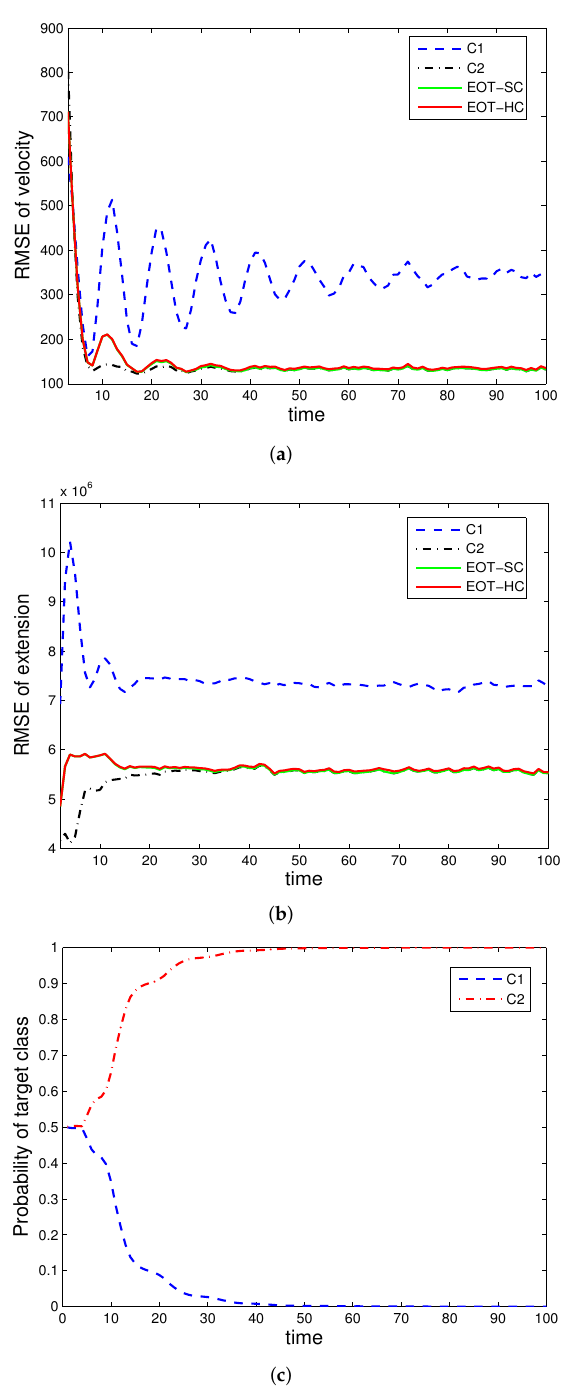
Figure 1 is the simulation results with only kinematic measurement under the true class c 1 ; Figure 2 is the simulation results with only kinematic measurement under the true class c 2 ; Figure 3 is the simulation results with both kinematic and attribute measurements under the true class c 1 ; Figure 4 is the simulation results with both kinematic and attribute measurements under the true class c 2 .